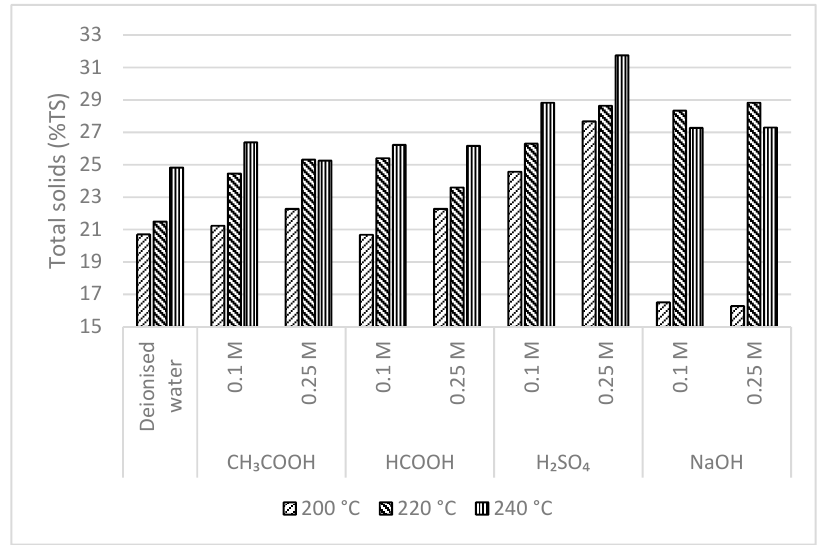
Figure 3. Dry matter concentration of hydrochar residue after filtering the process-water.